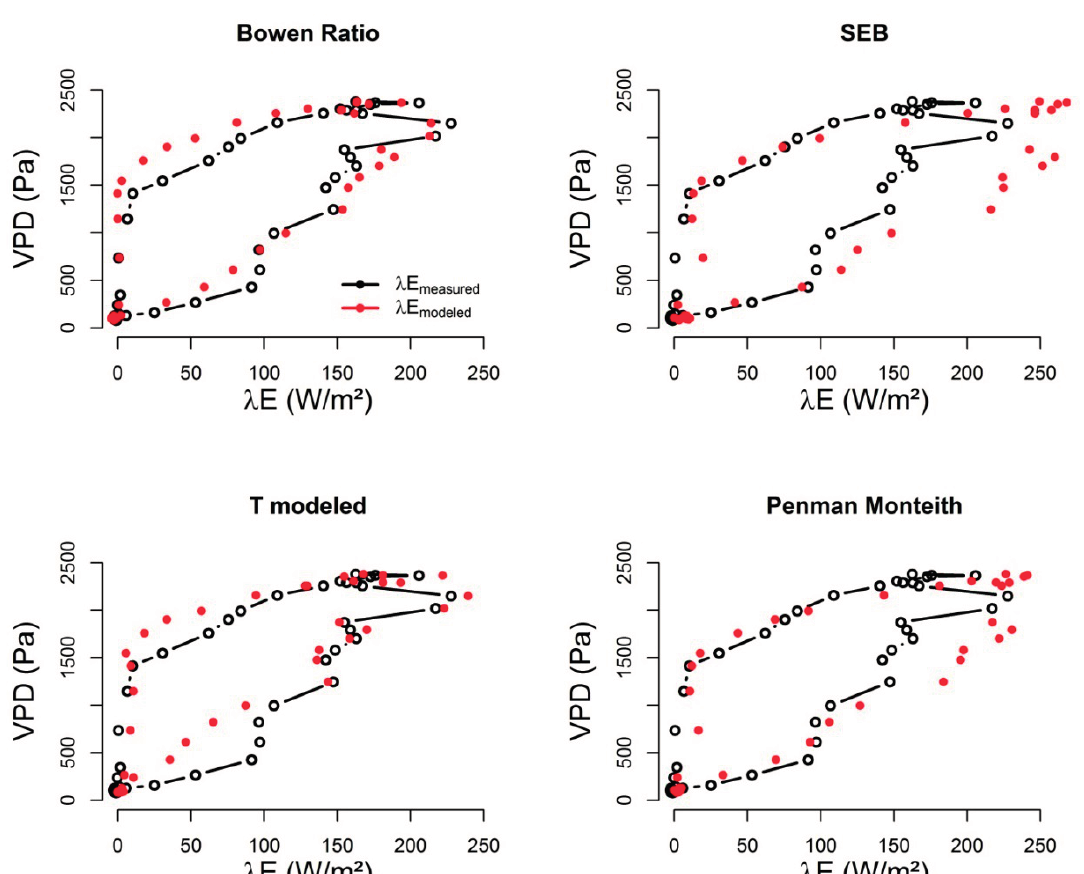
Figure 7. Scatter plot between the vapor pressure deficit of the air ( VPD ) with measured λ E (dotted black lines) and modeled λ E (red dots) for 23 July 2012, indicating the clockwise hysteresis effect caused by the phase angle difference between net radiation and VPD . For model abbreviations, cf. Table